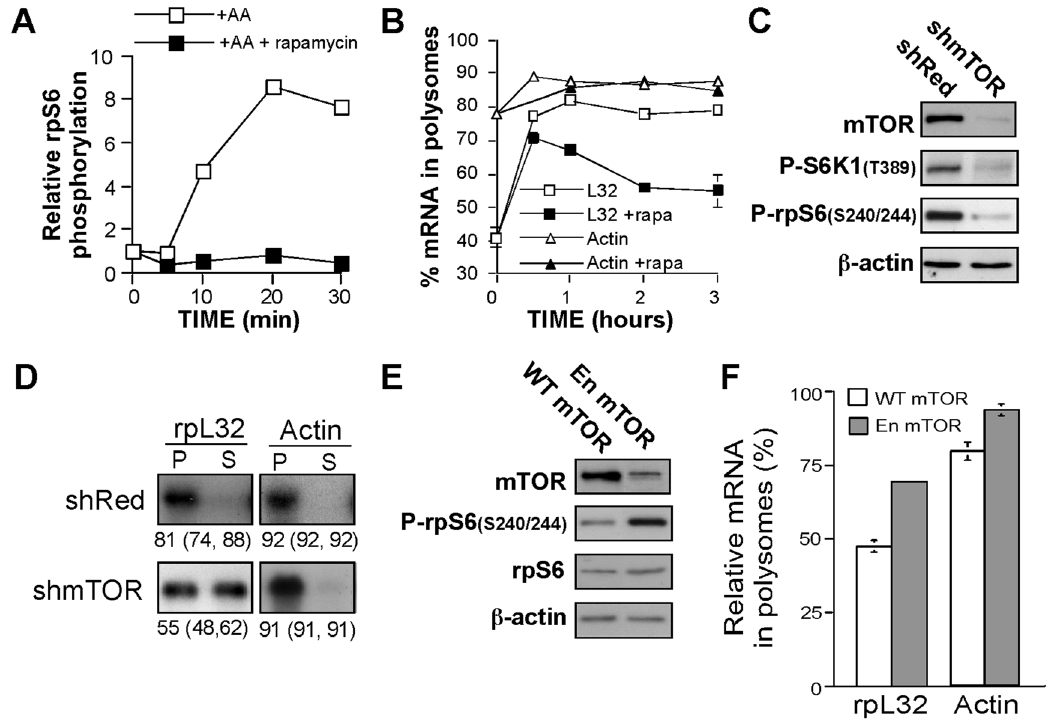
Figure 2. mTOR mediates amino acid-induced translational activation of TOP mRNAs. (A) Kinetics of the effect of rapamycin on mTORC1 activity. 293 cells were amino acid-starved for 2 h and then refed for the indicated time in the presence or absence of 20 nM rapamycin, after which cells were harvested. The cytoplasmic proteins were subjected to Western blot analysis with anti-rpS6 or anti-Phospho-rpS6 antibodies. The chemiluminescent signals of phospho rpS6 were quantified and normalized to those obtained for rpS6 within the same protein extract. The results are numerically presented relative to those obtained for amino acid-starved cells (time zero), which were arbitrarily set at 1. (B) Kinetics of the effect of rapamycin on polysomal association of TOP mRNAs. HEK293 cells were amino acid-starved for 3 h (time zero), and then refed in the absence (open symbols) or presence (filled symbols) of 20 nM rapamycin (rapa). At the indicated times cells were harvested and cytoplasmic extracts were subjected to polysomal analysis. The percentage of mRNA in polysomes at each time point is presented as an average of at least 2 measurements. (C) HEK293 cells were infected with viruses expressing HcRed (Red) shRNA or mTOR shRNA1. Cells were amino acid-starved for 3 h followed by 3 h amino acid stimulation on day 4 post-infection. The abundance of mTOR and its activity were monitored by Western blot analysis of cytoplasmic proteins with the indicated antibodies. (D) Cytoplasmic extracts from cells described in (C) were subjected to polysomal analysis. (E) and (F) HEK293 were transiently transfected with plasmid-based vectors expressing either wild-type (WT) mTOR or enhanced (En) mTOR. 48 h later cells were amino acid- starved for 3 h and harvested. Cytoplasmic proteins were subject to Western blot analysis (E) and cytoplasmic extracts to polysomal analysis (F). The percentage of mRNA in polysomes is presented as an average 6 SEM of three